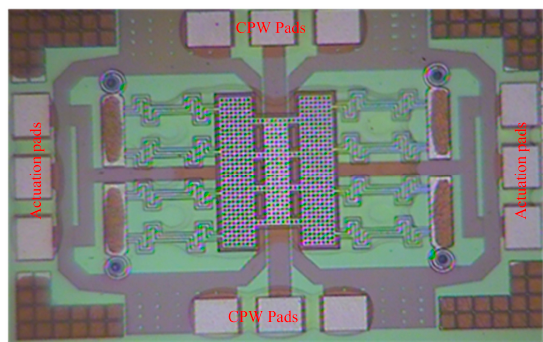
Figure 10. SEM image of the membrane.